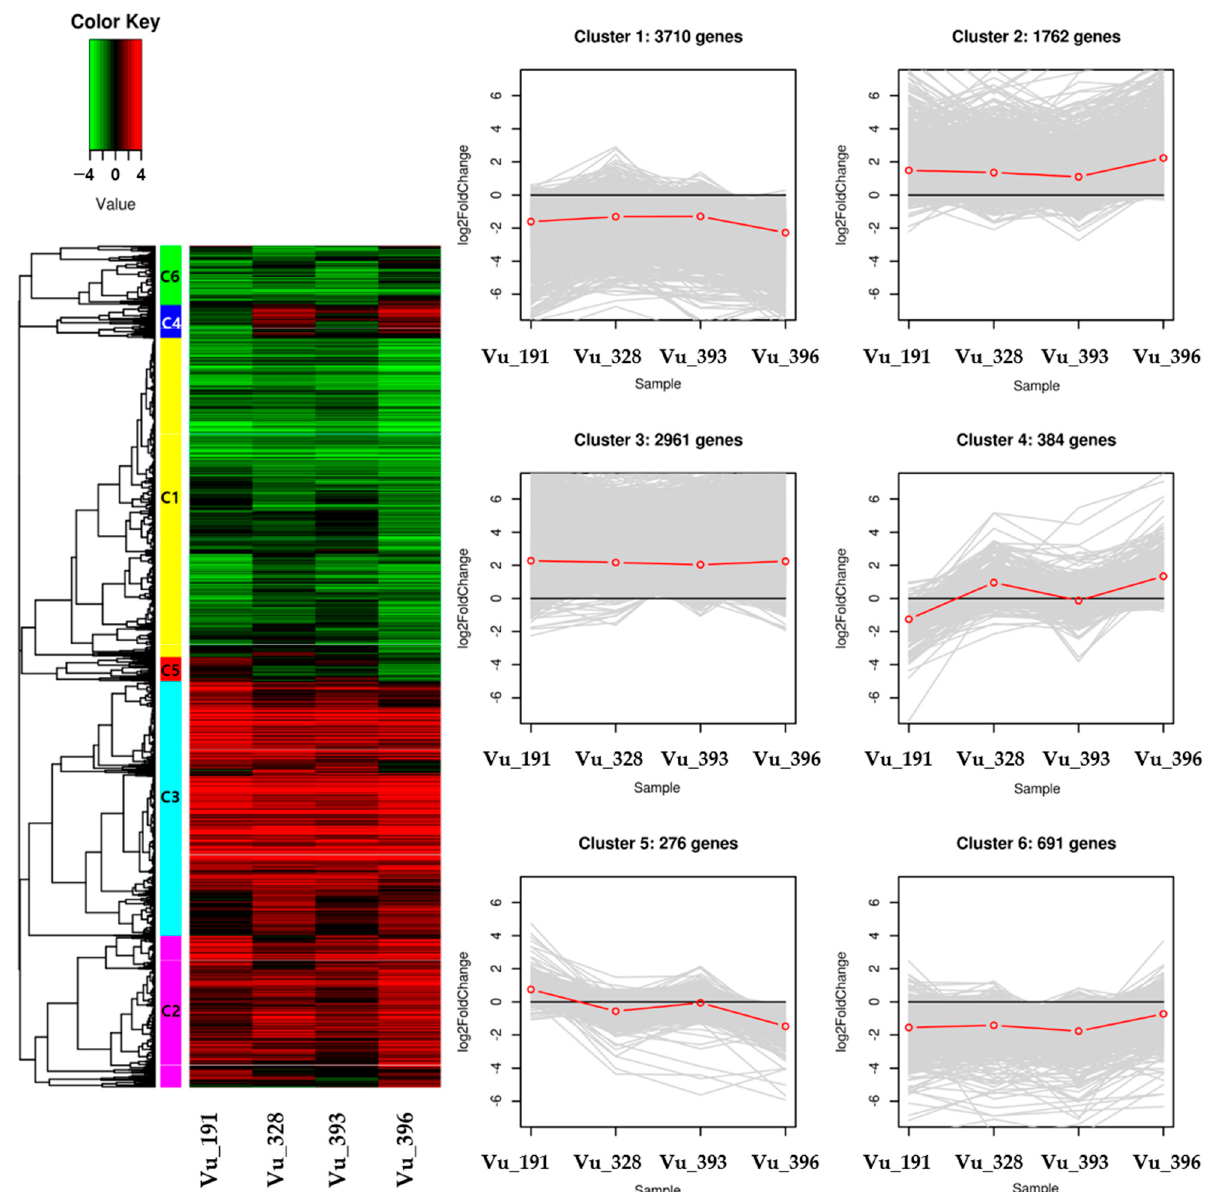
Figure 5. Heat map of the differential expression level of the genes in each cluster and line plots displaying the expressed clusters as patterns. The redline in line plots indicates the mean log 2 foldchange (FC) value in gene expression.